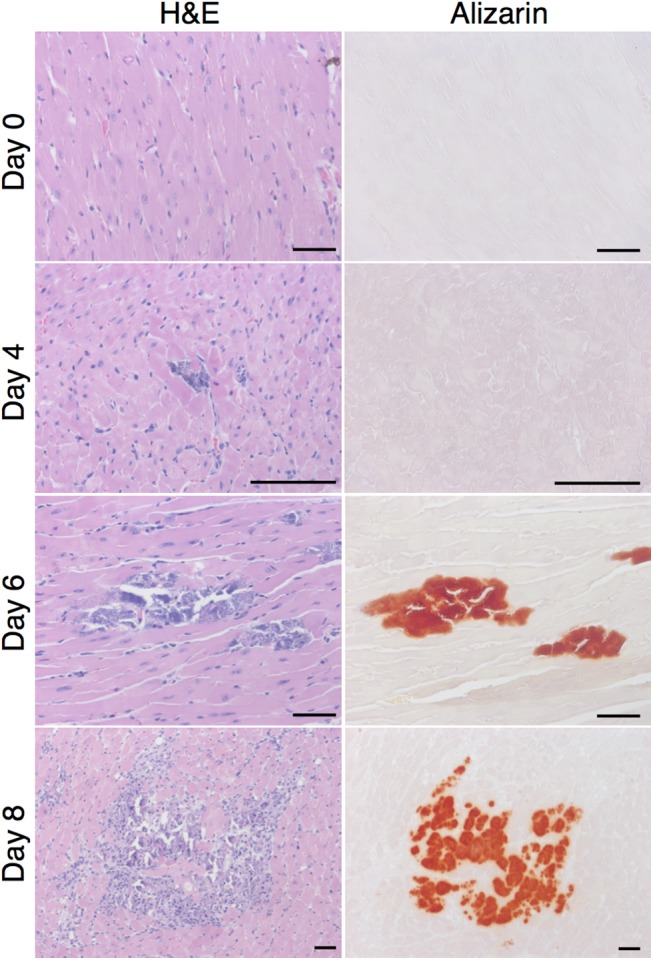
Spatio-temporal relationship between calcification and inflammation following CVB3 infection.Presence and location of calcification and inflammation were assessed at days 0, 4, 6, and 8 post infection in 129S1 mice using alizarin and H&E staining respectively. Normal histology was observed at day 0. Non-calcified lesions were observed 4 days post infection. These expanded in size and number by day 6 post infection at which time calcification became apparent. By day 8 post infection, inflammation was observed and colocalized completely with calcified lesions. Bar = 100μm.